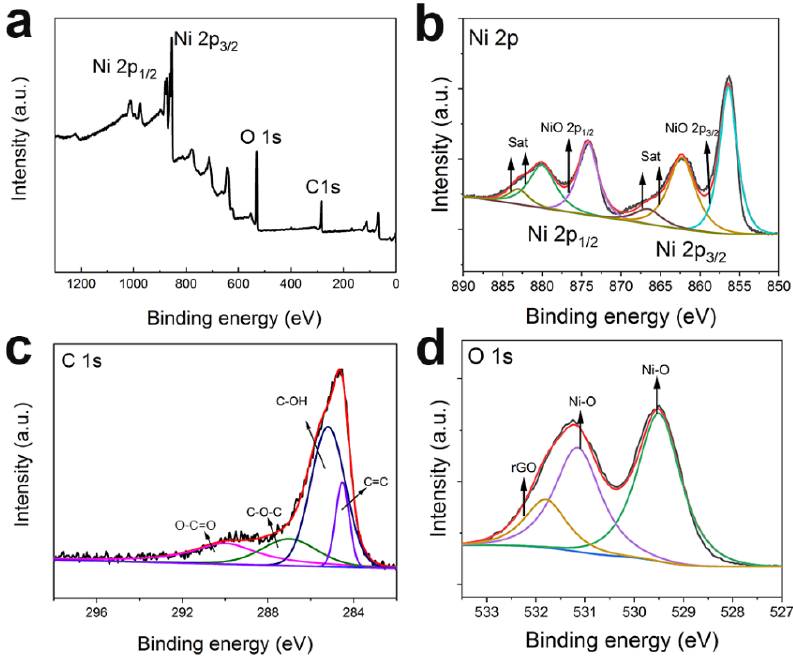
Figure 3. ( a ) XPS and high-resolution spectra of ( b – d ) Ni 2p, C 1s, and O 1s peaks in the NiO-rGO composite.